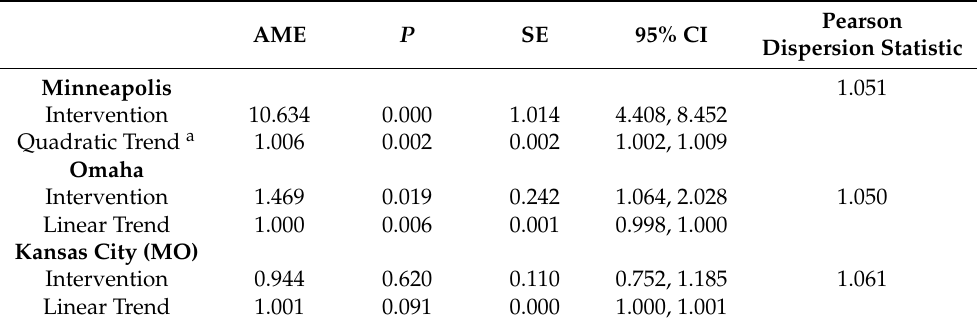
Table 1. Interrupted time-series analyses of the impact of the murder of George Floyd on the average number of weekly violent firearm incidents in three